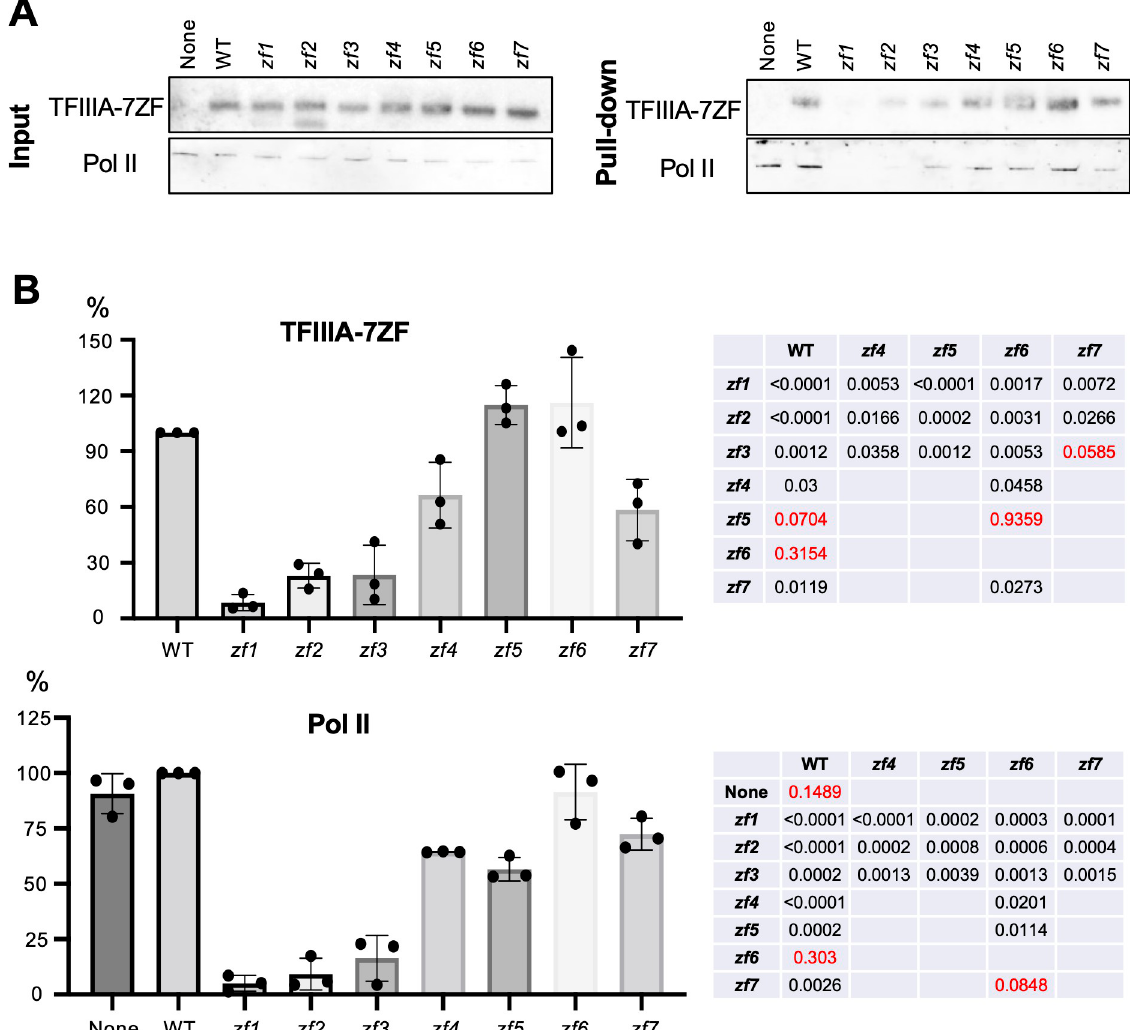
Fig 4. Analyses of the binding ability of TFIIIA-7ZF mutants. WT and mutants TFIIIA-7ZF proteins were used for RNA-based affinity purification in the presence of partially purified Pol II. (A) Immunoblots for input and RNA-bound TFIIIA-7ZF (anti-TFIIIA) and the Rpb1 subunit of Pol II (8WG16). Values from the samples with WT TFIIIA-7ZF were set as 100%. Data from samples with mutant TFIIIA-7ZF were normalized to the values of samples with WT TFIIIA-7ZF. None, no TFIIIA-7ZF protein was supplied. (B) Quantification of immunoblotting results in (A). Protein signals in Pull-down blots were normalized to the corresponding signals in the Input blots. The normalized signals in WT (TFIIIA and Rpb1) were set as 100%. Three replicates were performed for quantification and statistical analyses. A two-tailed T-test was used to calculate P values (listed in tables), by using the built-in function in Prism.